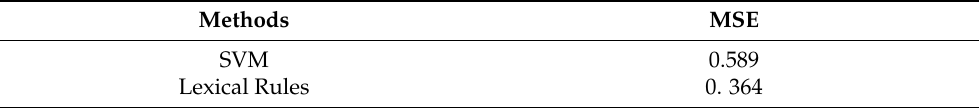
Table 4. MSE values of the lexical rules and